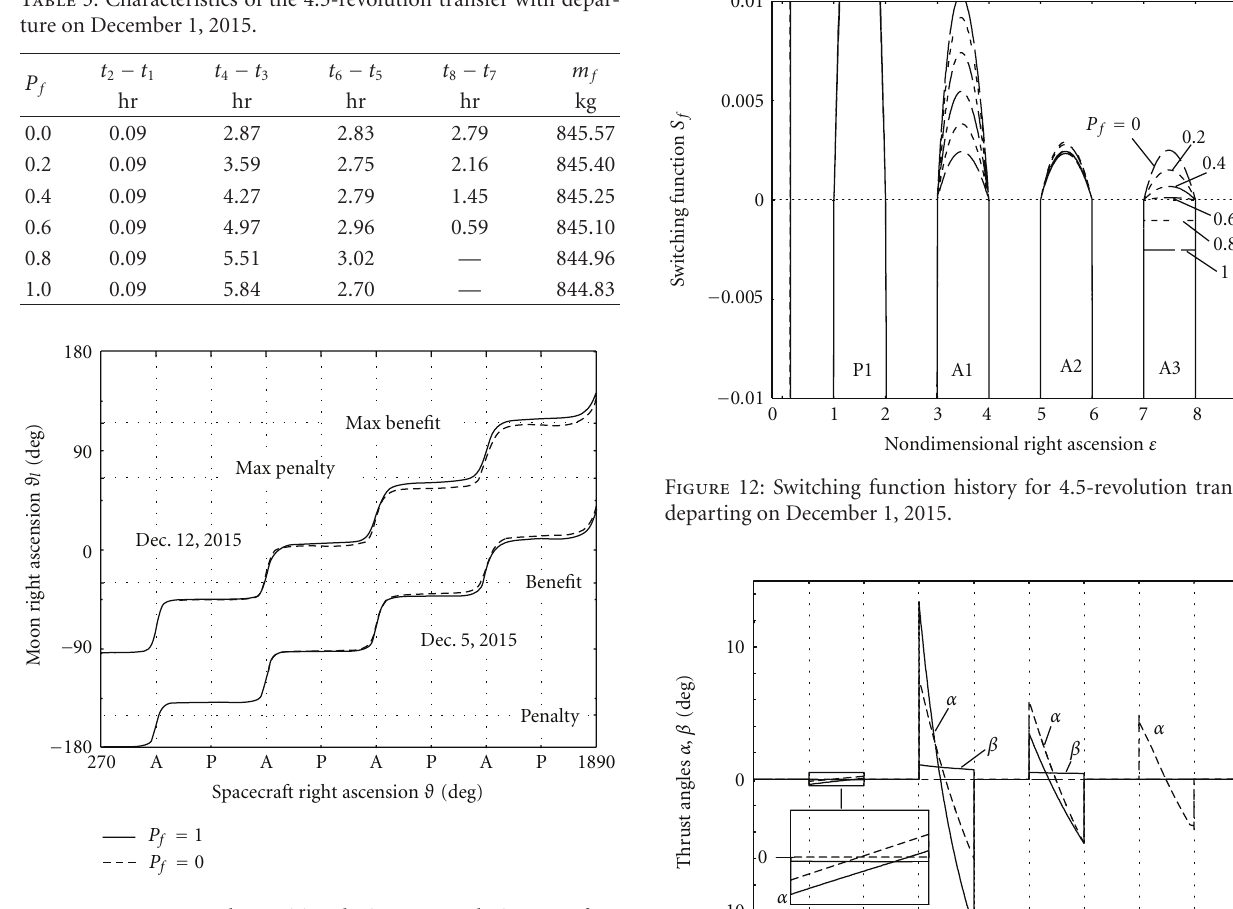
Figure 11: Moon angular position during 4.5-revolution transfers.